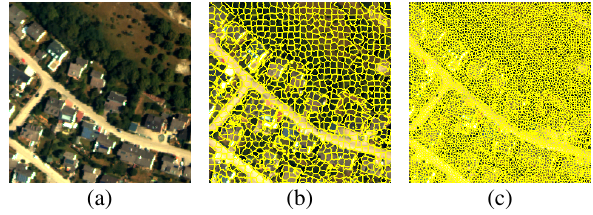
Figure 2. Visualization of different segmentation levels for Greding . (a) shows a section of the RGB image, (b) depicts the result with 1% and (c) with 4% of the total number of image pixels.